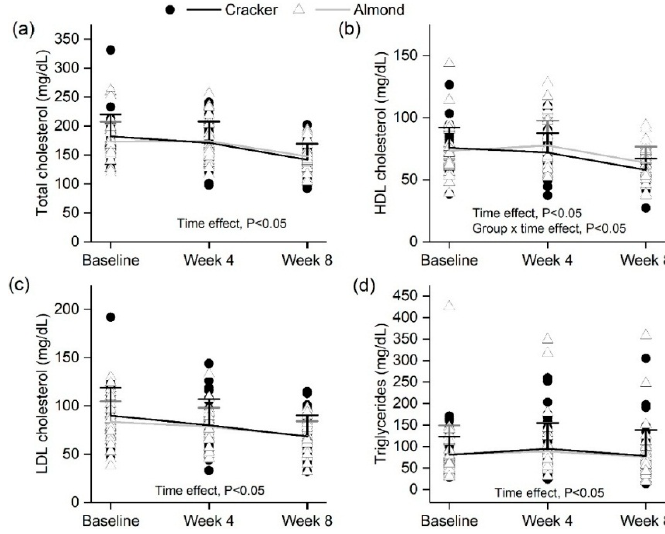
Figure 2. Fasting serum ( a ) total cholesterol, ( b ) HDL cholesterol ( c ) LDL cholesterol and ( d ) triglycerides profiles of the cracker and almond groups at baseline, week 4 and week 8 of the intervention. Values are individual data points representing each participant at baseline, week 4 and week 8. Means ± SDs of the 2 snack groups at baseline, week 4 and week 8 are also plotted. Analysis was conducted using a linear mixed effects model with week as within-subject factor and snack group as between-subject factor. Triglyceride values were transformed prior to analysis using Johnson’s family of transformations. Cracker: n = 35, Almond: n = 38. Total cholesterol time effect: baseline vs. week 8; week 4 vs. week 8, p < 0.05. HDL cholesterol time effect: baseline vs. week 8; week 4 vs. week 8, p < 0.05. LDL cholesterol time effect: baseline vs. week 4, p < 0.05; week 4 vs. week 8, p < 0.05. Triglycerides time effect: week 4 vs. week 8, p < 0.05.